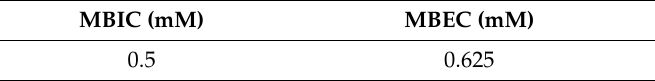
Figure 6. The bio dispersion activity of the SCGS on the metal surface against the environmental sulfidogenic bacteria at 5.49% salinity. ( a ) the cultivated sample ( b ) the coupons after washing ( c ) the bio-dispersion activity of the SCGS with concentration of 5, 2.5, 1.25, and 0.625 mM. The figure showed that the concentration of 1.25 mM is the MBEC of the SCGS on the metal surface against the environmental sulfidogenic bacteria at 5.49% salinity. Table 5. The minimum biofilm inhibitory concentration (MBIC) and minimum biofilm eradication concentration of the SCGS against sulfidogenic diversity developed bacterial biofilms. The result was represented as the mean of the sample concentrations (mM) with zero standard deviations (SD).